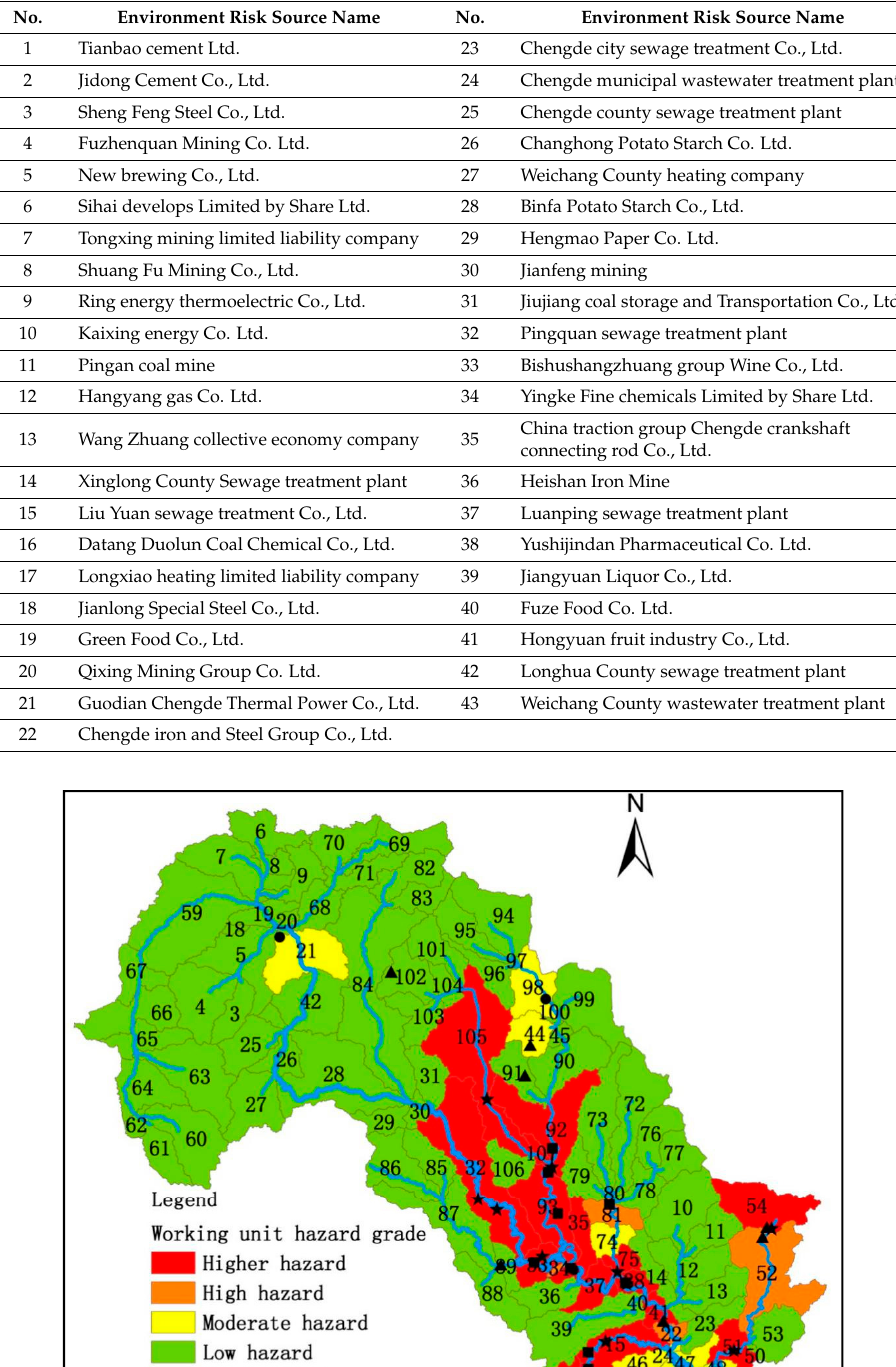
Table 7. Environment risk source name.